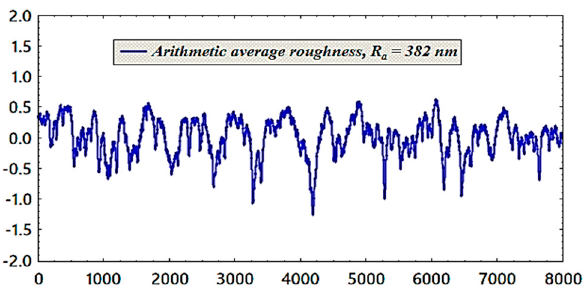
( b ) Figure 3. ( a ) Schema of the pool boiling apparatus, ( b ) real picture of the pool boiling apparatus. Before starting the tests, the pool boiling chamber was cleaned with a water jet and dried to remove all dirt. Next, the roughness of the heating surface was measured by a surface roughness tester (type: Mitutoyo SJ-400, Mitutoyo, Japan) to obtain the roughness of the polished copper tube before the boiling process. The average of six measurements along the tube with different radial and axial locations were taken to calculate the arithmetic mean roughness parameter (R a ). The roughness was 0.382 μ m, as shown in Figure 4. Afterwards, the working fluid was injected through an injection hole from the top of the chamber. Following this, to heat the liquid to the saturation temperature, the auxiliary heater with a capacity of 400 W was switched on. When the temperature of the bulk fluid reached the saturation temperature, removing any dissolved bubbles inside the chamber, the boiling process was kept for 10 min to remove all those dissolving bubbles. In this research, the boiling points at the atmospheric condition were measured for both water and nanofluids in the same condition. Therefore, the measurements revealed that the water boiling point was higher than the nanofluid boiling point by about 0.2 °C, and this was within the range of the error of the temperature logger. Hence, the boiling point for both deionized water and nanofluid has been assumed to be the same, and this was observed in earlier studies of [19,38]. The next stage was to switch on the cartridge heater